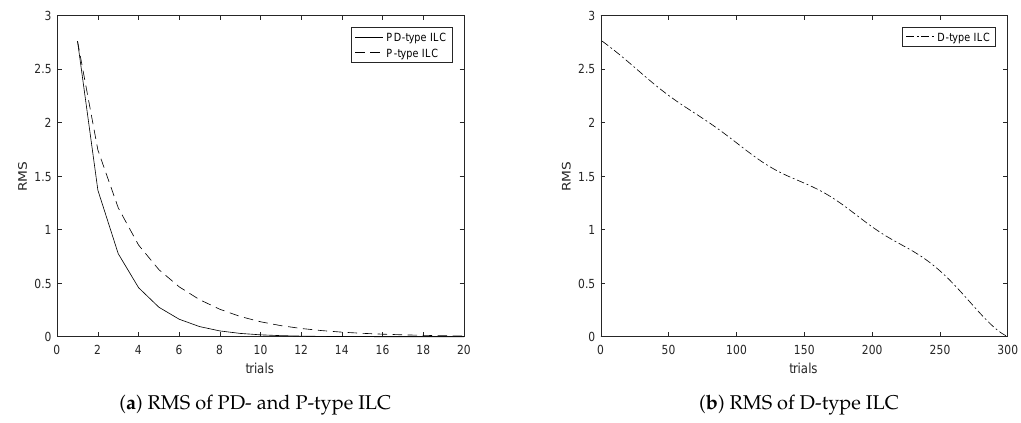
Figure 5. RMS of PD-, P- and D-type ILC for nominal